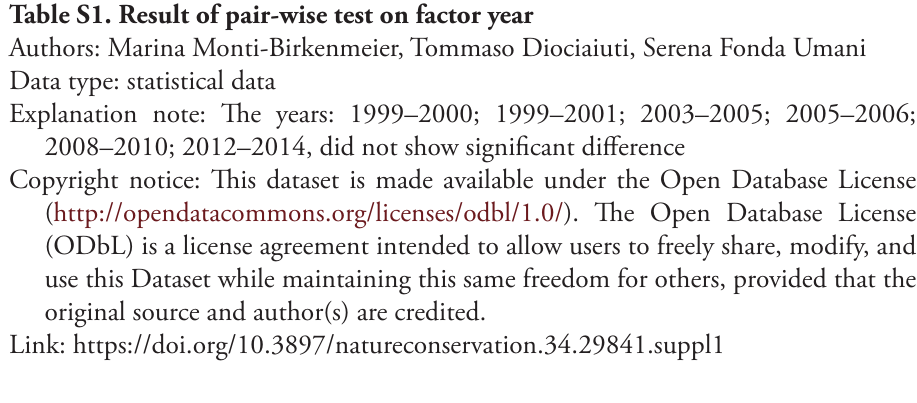
Table S1. Result of pair-wise test on factor year